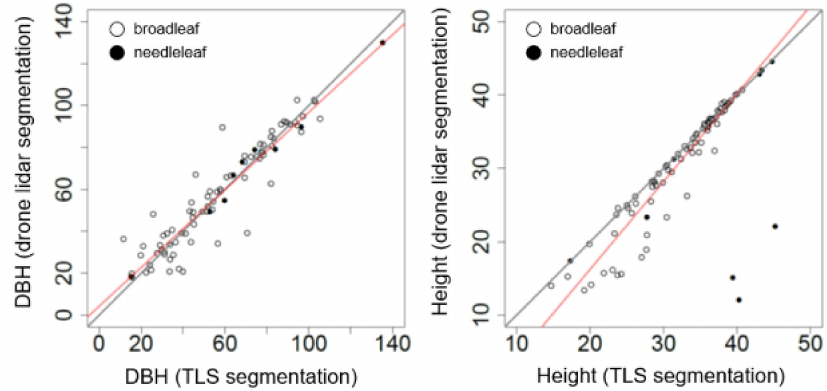
Figure 5. Relationships between DBH and height for trees segmented using high-density drone lidar and TLS. Left: The DBH relationship for individual trees segmented using drone lidar and TLS. Right: The height relationship for individual trees segmented using drone lidar and TLS. Height is derived from the segmented points that passed the intensity filter, not from all measurements acquired by drone lidar. Grey lines are the 1:1 relationship. Red lines are linear regression.